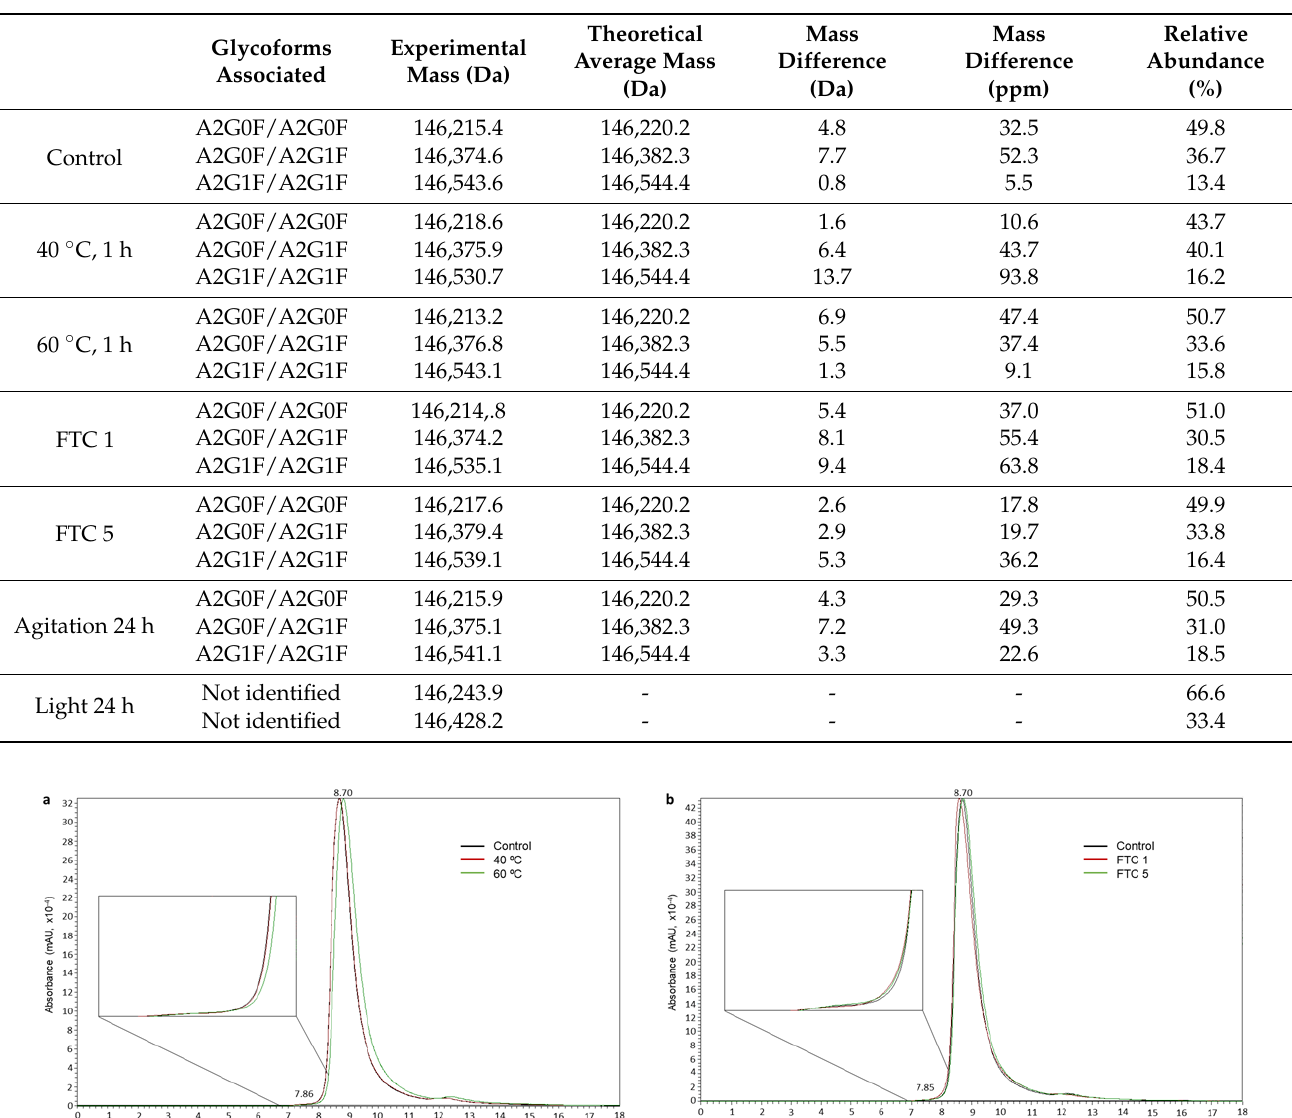
Table 5. Experimental masses for intact nivolumab in native conditions for control and stressed samples. The relative abundances of N-glycoforms are also reported. Theoretical masses were calcu- lated considering two C-term lysine clipping, two N-term pyroglutamate formation and 16 disul- phide bonds.